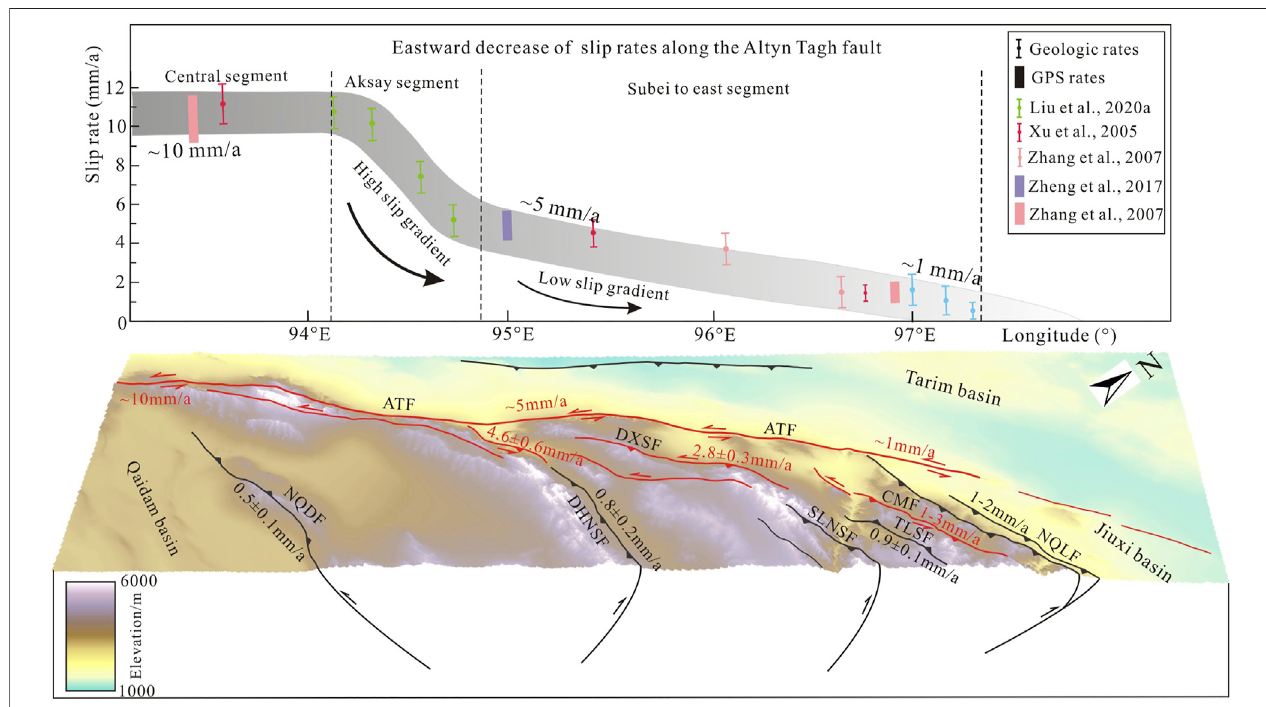
FIGURE 10 | Spatial variation of slip rates along the Altyn Tagh fault and three-dimensional DEM map of the western Qilian Shan. The upper fi gure shows an eastward decrease of slip rates along the Altyn Tagh fault, exhibiting steady slip rates in the central segment, a high slip gradient in the Aksay segment and a low slip gradient from Subei to the east segment (modi fi ed from Liu J. et al., 2020). In the DEM map, the black lines and numbers represent reverse faults and thrusts and its shorteningrates;thered lines and numbers represent sinistralstrike-slipfaults andits sinistral sliprates.Abbreviationsoffault names:ATF, AltynTagh fault;NQDF, Northern Qaidam fault; DHNSF, Danghe Nan Shan fault; SLNSF, Shule Nan Shan fault; TLSF, Tuolai Shan fault; CMF, Changma fault; NQLF, Northern Qilian